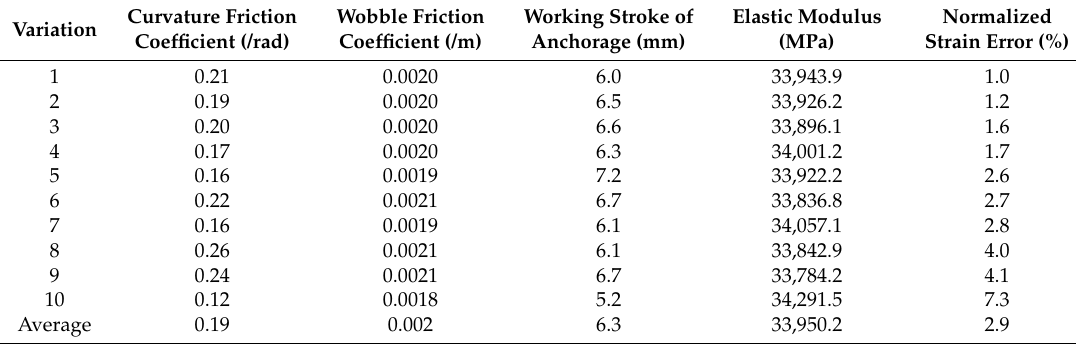
Table 2. Optimization results for variations where the strain measured by the smart strand shows definite